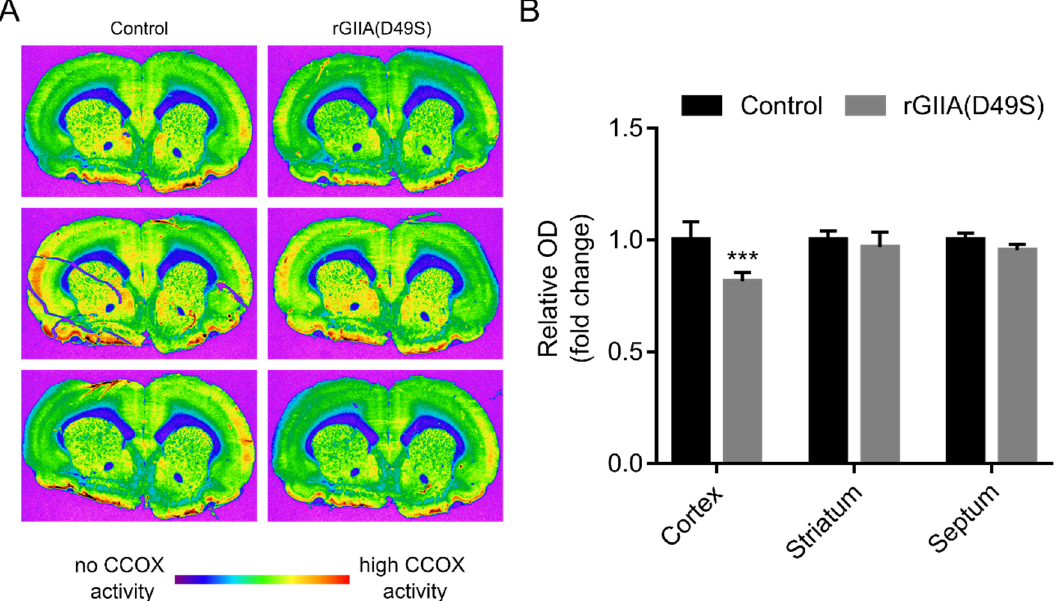
Figure 6. rGIIA(D49S) also affects the enzyme activity of CCOX ex vivo in tissue sections of rat brain. ( A ) Rats were sacrificed and coronal cryostat sections (10 µm) were cut through their rostral hippocampus. Consecutive sections were histochemically stained for CCOX activity in the presence or absence (control) of 10 µM rGIIA(D49S) and were imaged using a sensitive black-and-white video camera (see Materials and Methods section for details). Different shades of grey corresponding to different CCOX activity levels were visualized in the pseudo-color spectrum, using MCID M4 image-analysis software. Magnificaation 1.4×. ( B ) Densitometric analysis of the CCOX staining on cryosections from (A) in different ROIs: cerebral cortex, striatum and septum. Results are presented as means ± SD of fold change in relative optical density (ROD) compared to ROD of untreated sections from three independent experiments, and results that were statistically significantly different from the control are indicated (*** p < 0.001; two-way ANOVA with Bonferroni’s post-hoc test).